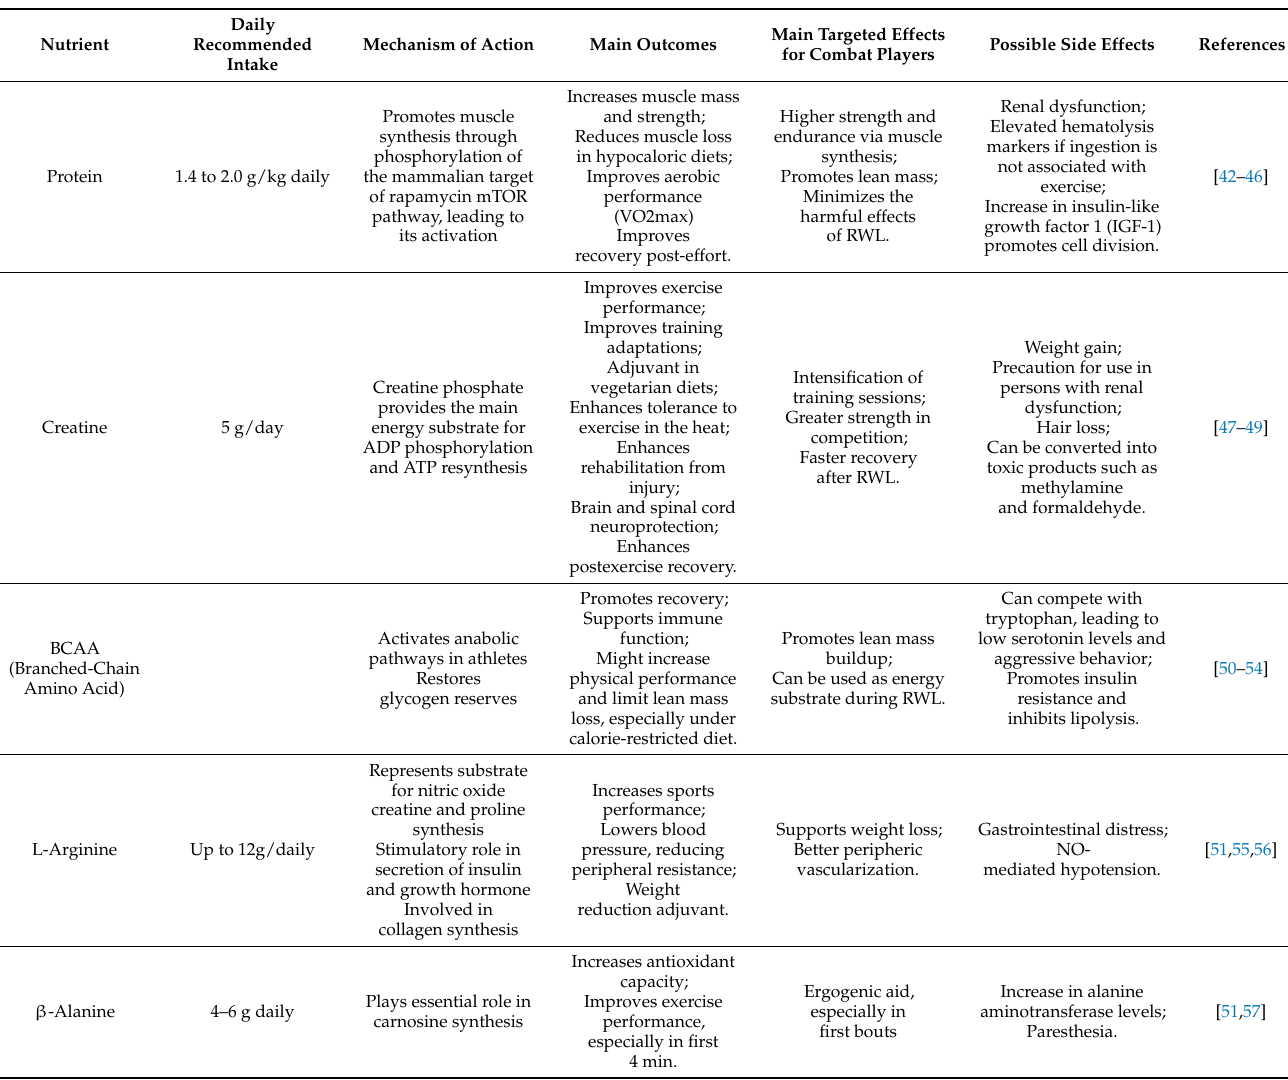
Table 3. The main nutrients required in the daily diet of combat players, the mechanisms of action, main outcomes, targeted effects for combat players and possible side